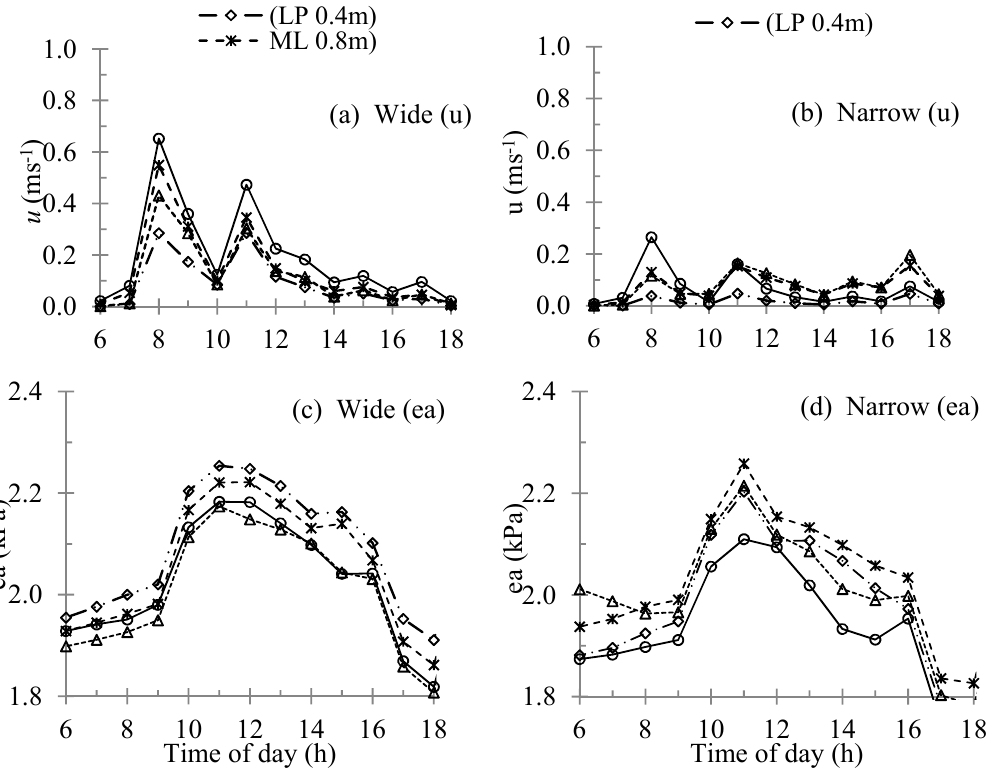
Figure 5. Hourly windspeed ( u ) and water vapor pressure ( ea ) at four heights for the narrow and wide strips throughout the day, 21 February 2009 (62 DAP), ( a ) Wide ( u ), ( b ) Narrow ( u ), ( c ) Wide ( ea ), ( d ) Narrow ( ea ).